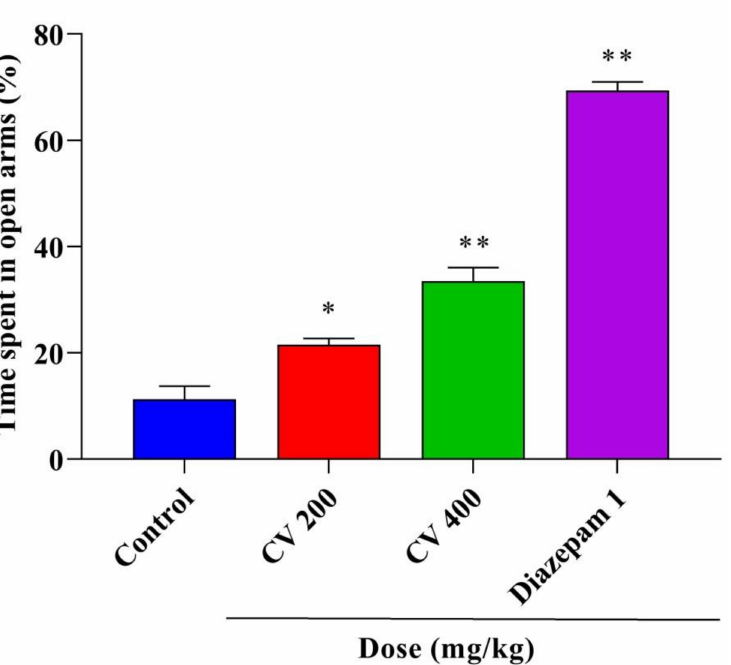
Figure 2. Anxiolytic activities of the methanol extract of Cnesmone javanica (CV) and diazepam as assessed by the elevated plus maze test. Significant differences (* p < 0.01 and ** p < 0.001) were assessed using one-way analysis of variance (ANOVA, followed by Dunnett’s test).